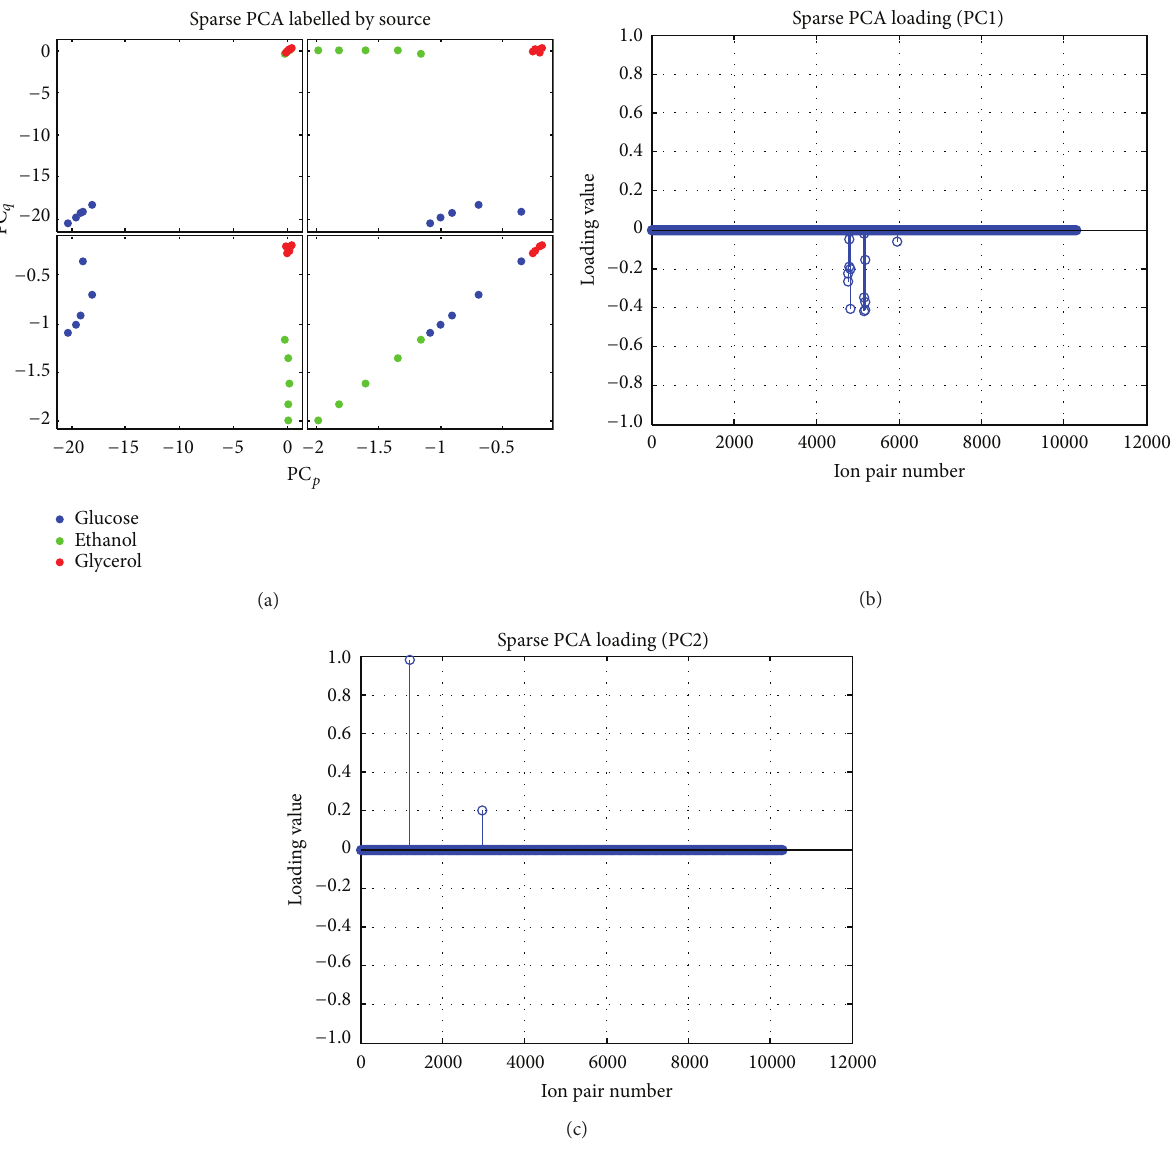
Figure 5: Sparse PCA and loading show the clustering of different C-source (including both ESI modes) and 5 replicates based on yield/slope of metabolite